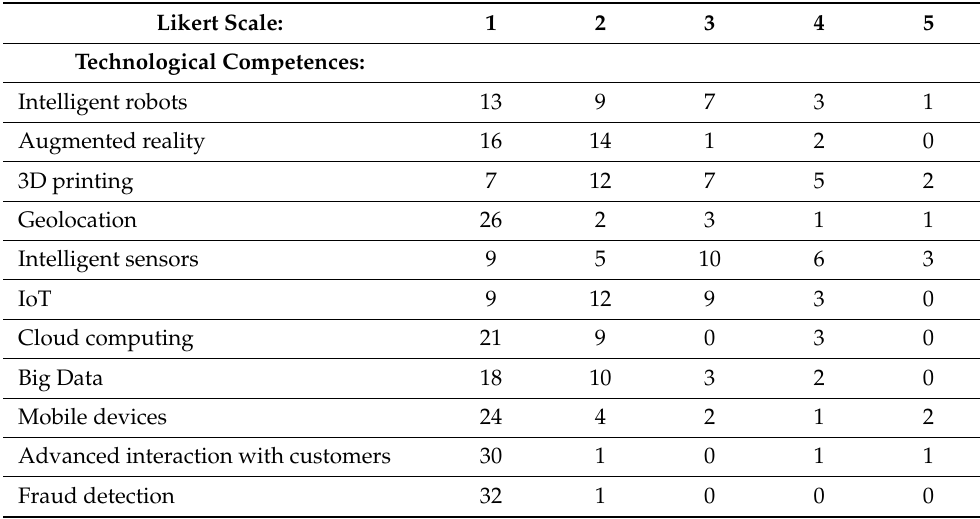
Table 2. Assessment of the respondents’ knowledge about innovative technologies on the Likert scale.